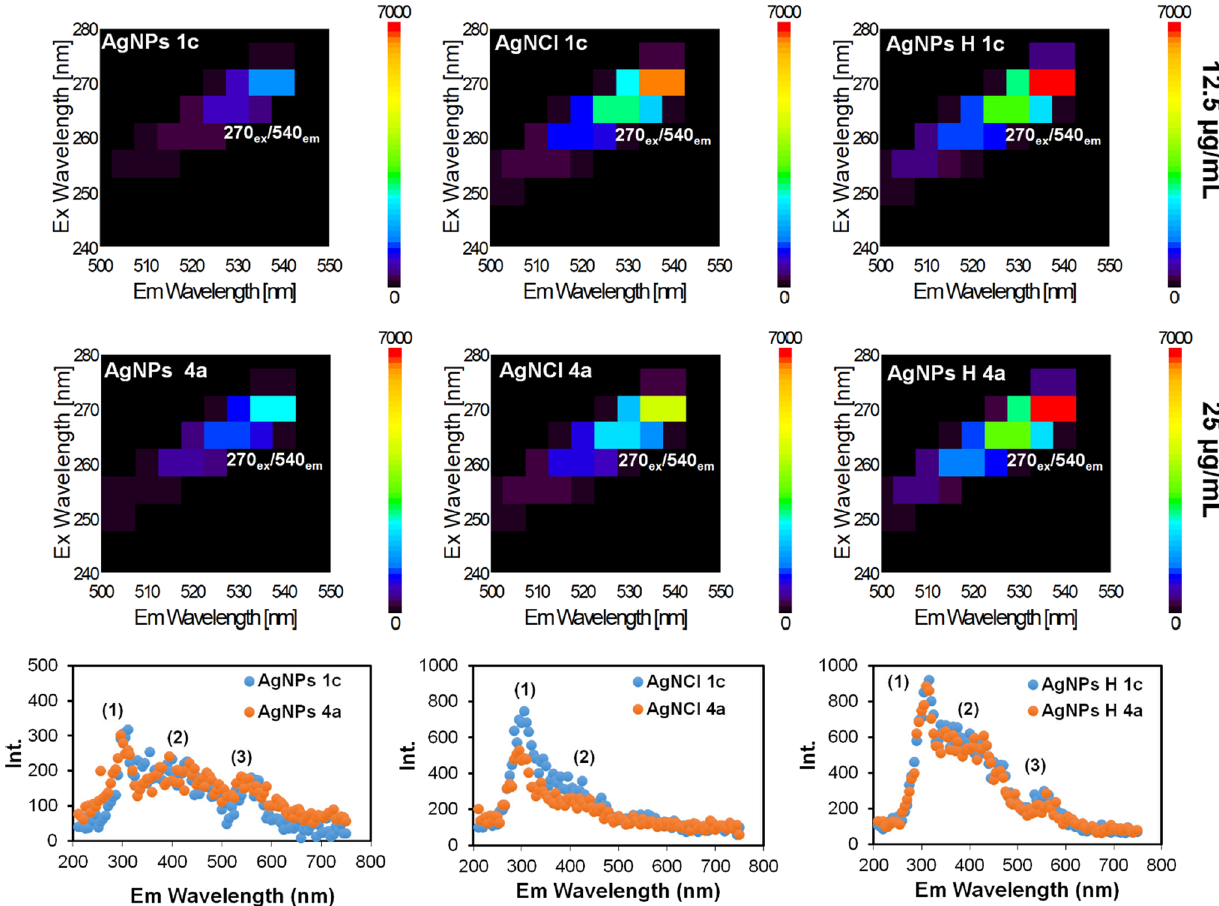
Fig. 8 Fluorescence analysis illustrating the fluorescence generated by both silver core and organic deposits recorded in all mediated (Bio) NCs